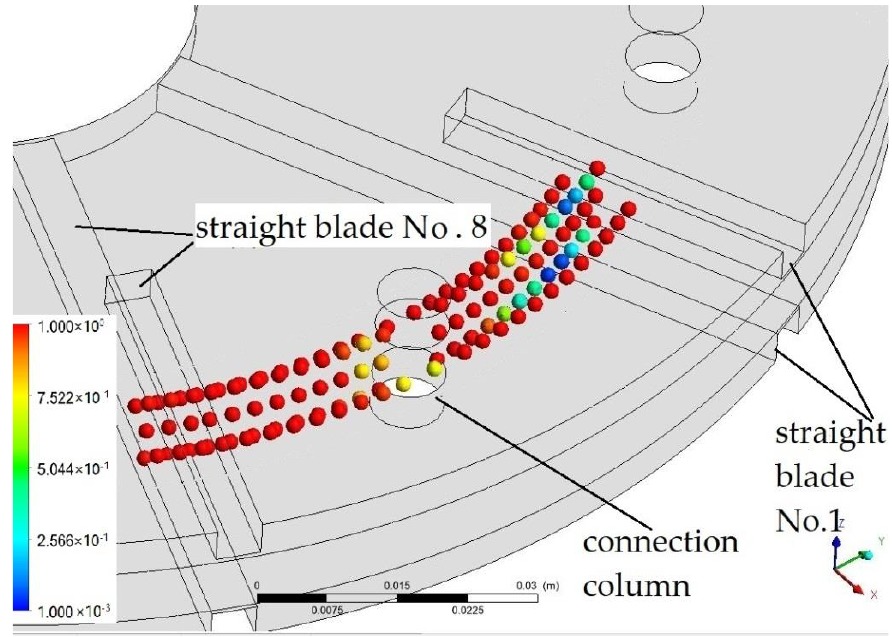
Figure 15. Spatial distribution of measuring points inside the impeller. (the different color of balls shows the different liquid volume fraction)